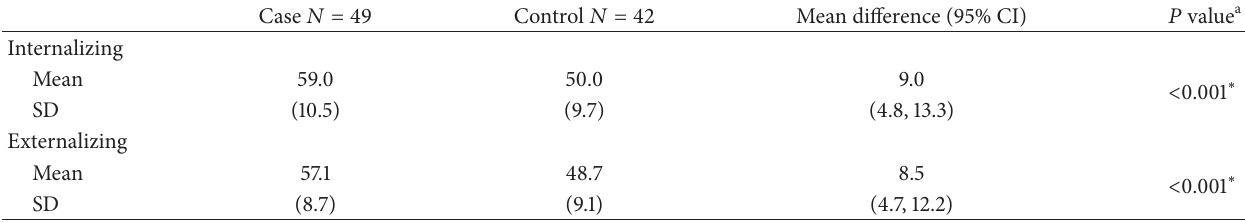
Table 3: Mean 𝑇 scores and mean differences for summary scales for cases and